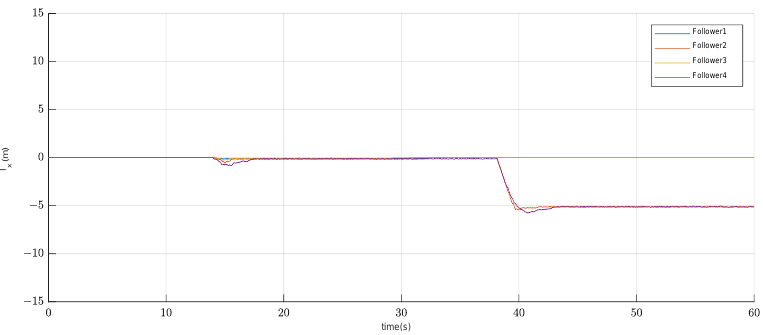
for each follower during the movement. 𝑙𝑙 𝑥𝑥